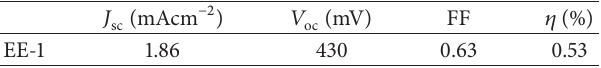
Table 2: Photovoltaic performances of DSSC.